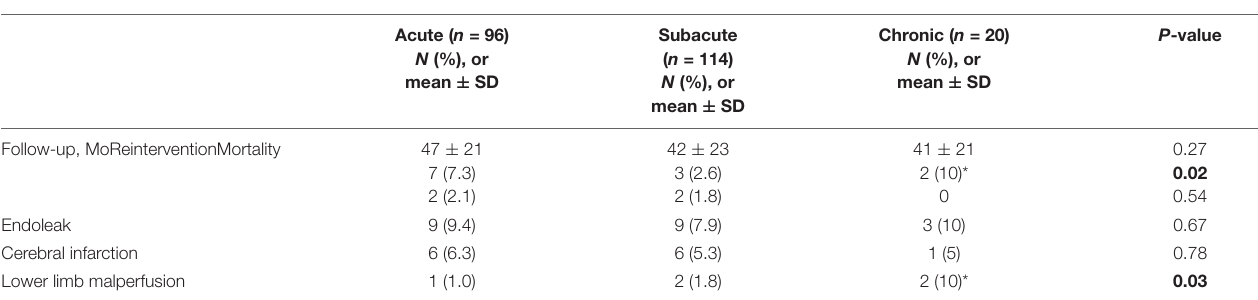
TABLE 3 | Follow up results and aortic remodeling after